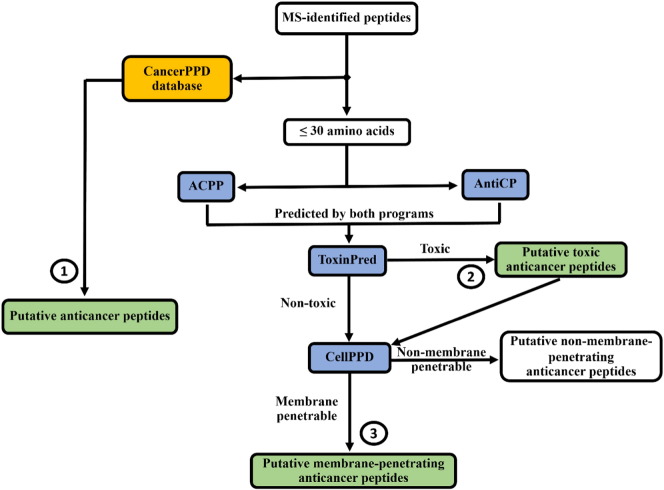
Workflow for bioinformatic prediction of putative anticancer, cytotoxic and membrane-penetrating peptides (labeled with numbers 1, 2 and 3) obtained from peptidomic analysis of A. fulica mucous fractions. Details were described in the text. CancerPPD (yellow box) was a database of anticancer peptides. ACPP, AntiCP, ToxinPred and CellPPD were the bioinformatics prediction programs (blue boxes).